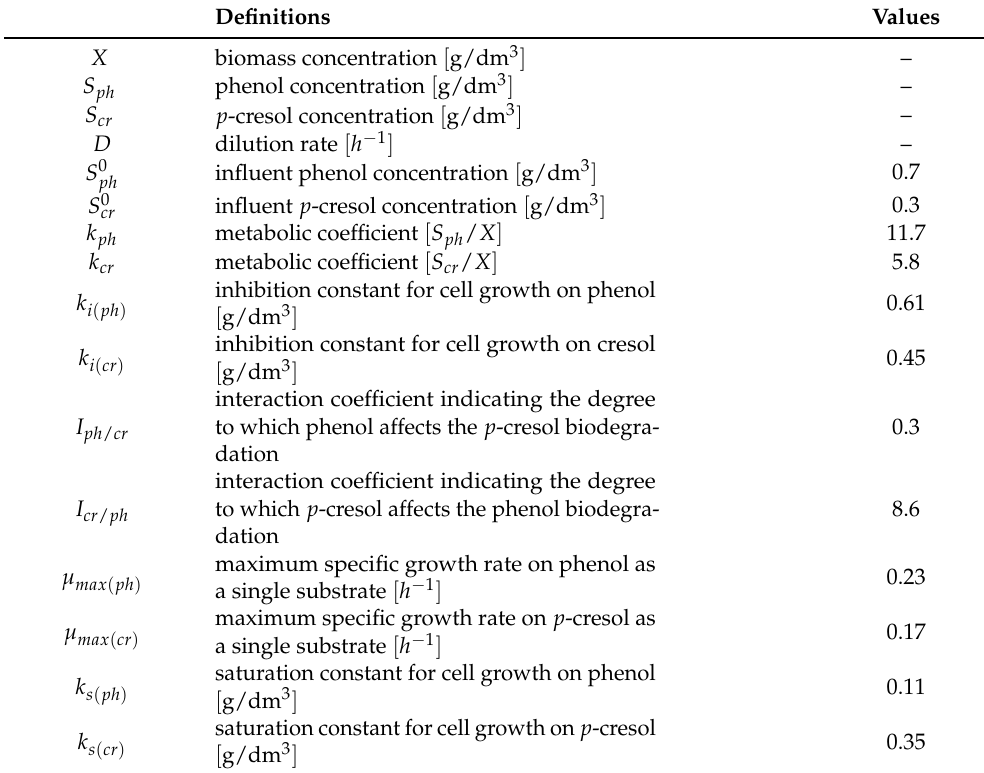
Table 1. Model variables and